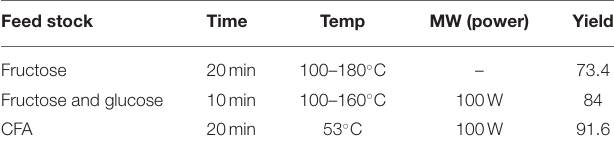
TABLE 3 | Summary of enhanced activity site of microwave on